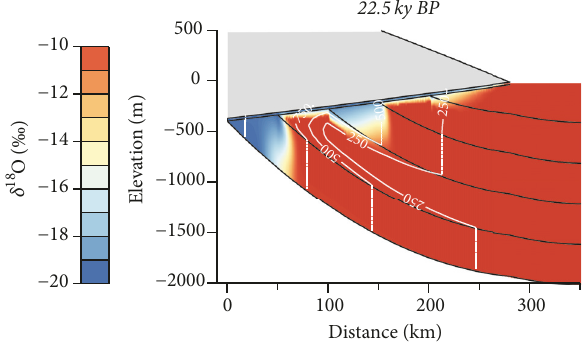
Figure 7: Hydraulic heads and 𝛿 18 O in simulation D1 during the growth of the ice-sheet. White lines are hydraulic head